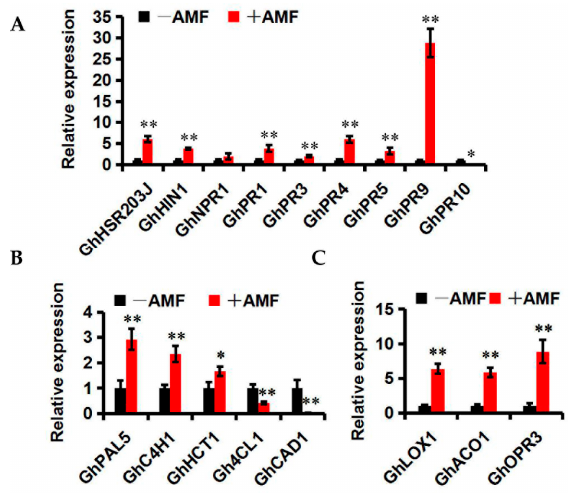
Figure 6. Expression patterns of cotton resistance-related genes in mycorrhizal (+AMF) and nonmycorrhizal ( − AMF) Lumian 1. ( A ) Expression of PR genes; ( B ) Expression of JA synthesis-related genes; ( C ) Expression of lignin synthesis-related genes. The test was performed using reverse transcription quantitative PCR analysis of relative gene expression. Transcript abundance of genes was normalized to that of the reference gene UBQ7 (GenBank Accession Number: DQ116441). Three biological replicates were used for each reaction with three technical replicates each. Mean values and standard errors were calculated from three biological replicates. * p < 0.05; ** p < 0.01.